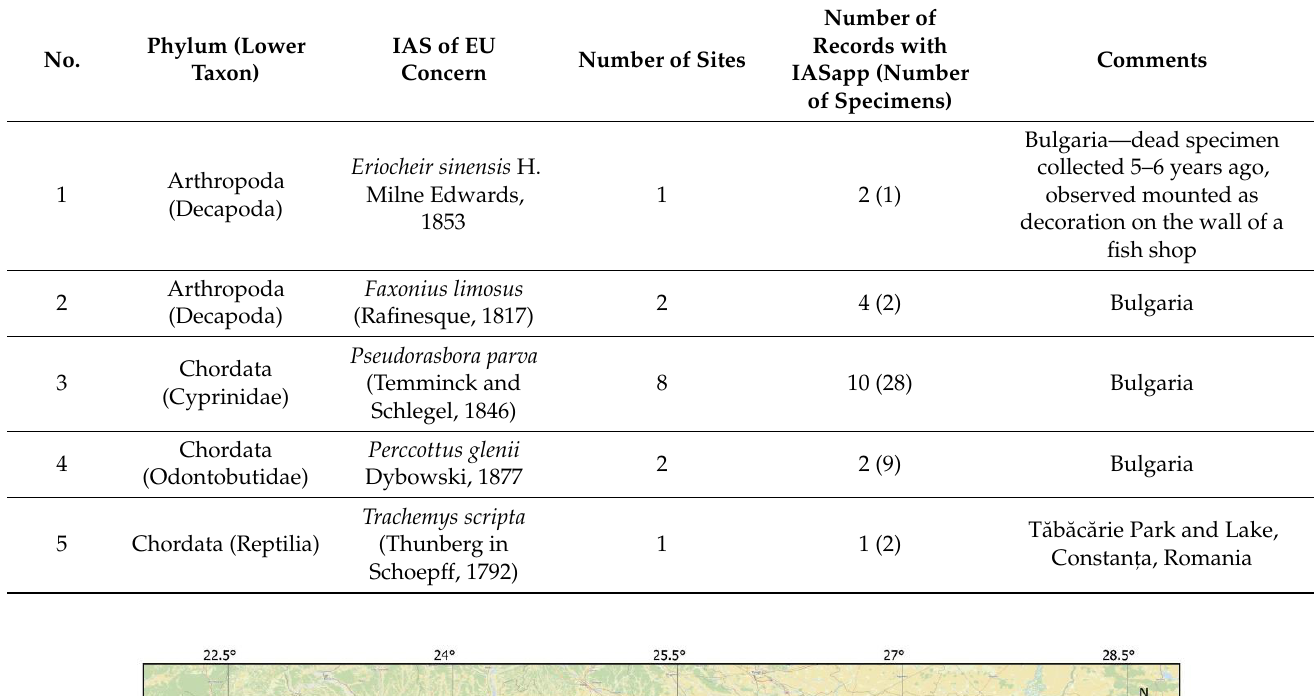
Table 2. Invasive alien species of EU concern recorded with ‘Invasive Alien Species in Europe’ app (IASapp), during the field testing in the Lower Danube Region in 2016–2017.